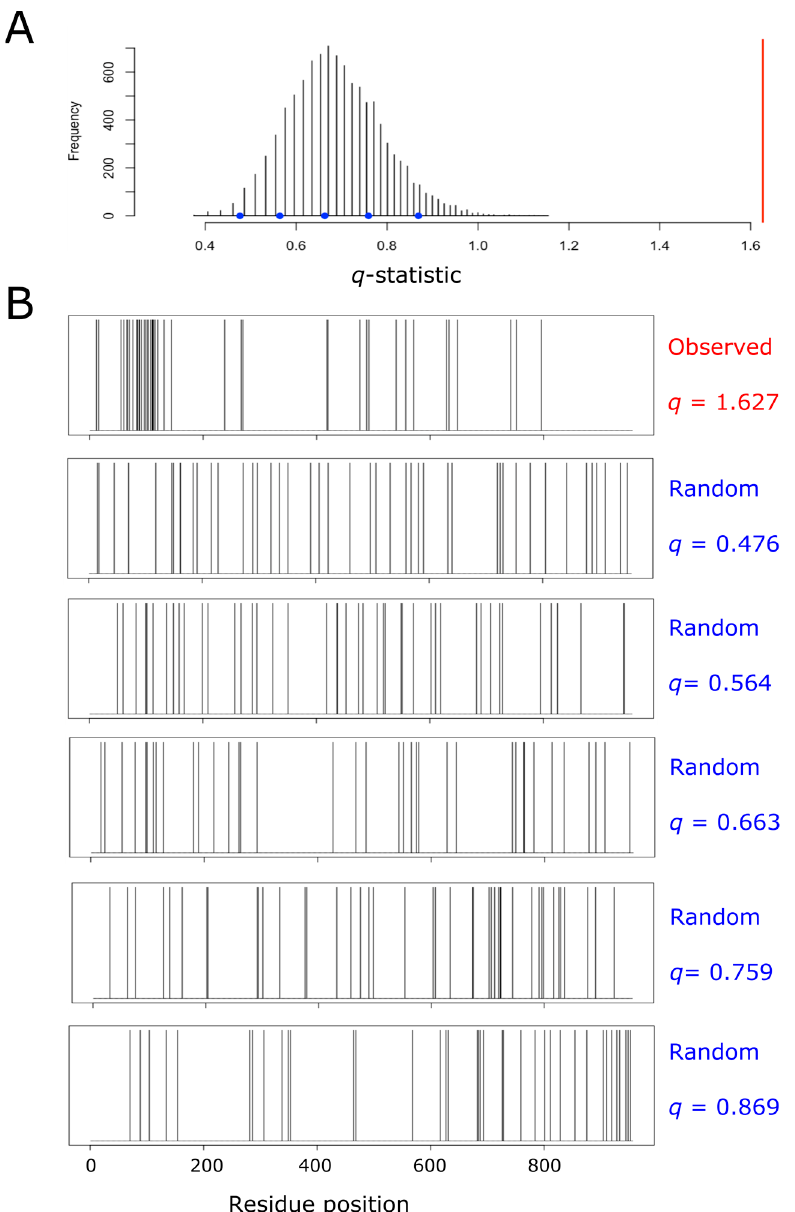
Figure 1. Empirical null distribution of the q -statistic for the protein pre-mRNA-processing factor 40 homolog A. This protein (O75400, UniProt ID) has been taken as an example to illustrate the process leading to the detection of methionine residue clustering, and the subsequent labeling of the protein as a member of the ‘aggregation’ category. The protein, which is 956 amino acids long, contains 42 methionyl residues (once the initiation methionine has been removed). Thus, we randomly distributed 42 methionine residues across a sequence of 956 amino acids, and computed the resulting value of the coefficient of variation ( q ). This process was repeated 10,000 times, and the resulting distribution of the statistic q was plotted ( A ). The spatial distribution of methionine residues across the protein sequence is shown in ( B ). The top plot from ( B ) correspond to the real observed distribution for the protein being analyzed. The value of q computed for this protein was 1.627, and it is indicated by the red vertical line in ( A ). The remaining five plots displayed in ( B ) show the dispositions of methionine across the lineal sequence when randomly distributed at different values of q , as indicated by the blue circles in ( A